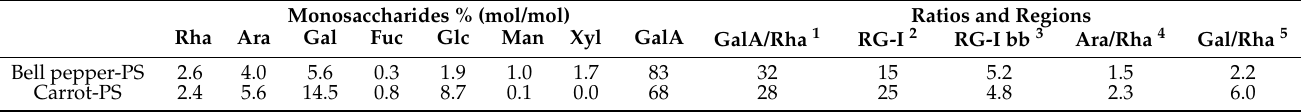
Table 3. Monosaccharide composition of lab-scale bell pepper-PS and carrot-PS hot water extracts. Monosaccharides % (mol/mol)